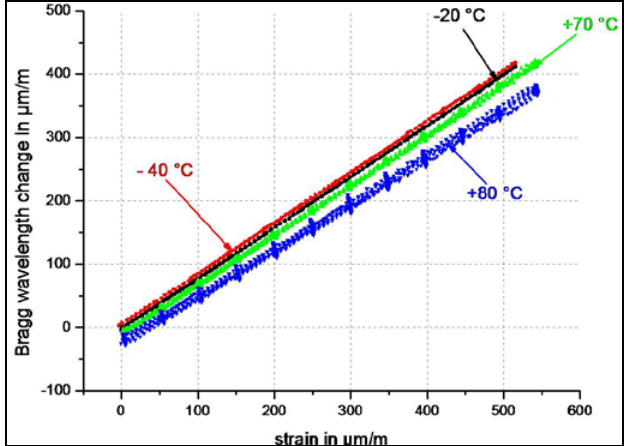
Figure 9. Change in Bragg wavelength of a patch compared to the strain determined with resistance strain gauges at different